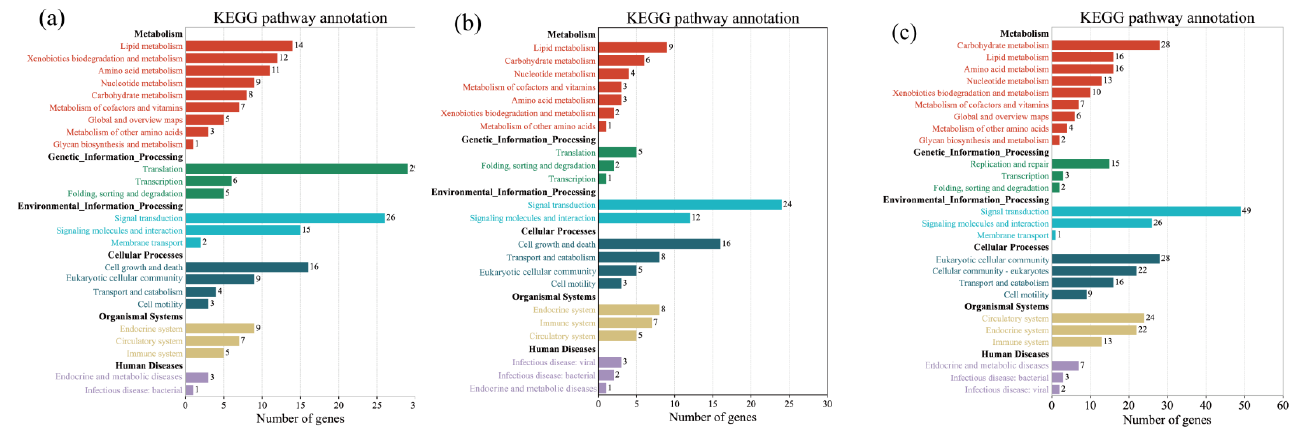
Figure 5. Annotation diagram of the KEGG pathway. ( a ) Annotated diagram of Smsh vs. Smsc KEGG pathway. ( b ) Annotated diagram of Smsh vs. Smsl KEGG pathway. ( c ) Annotated diagram of Smsl vs. Smsc KEGG pathway.